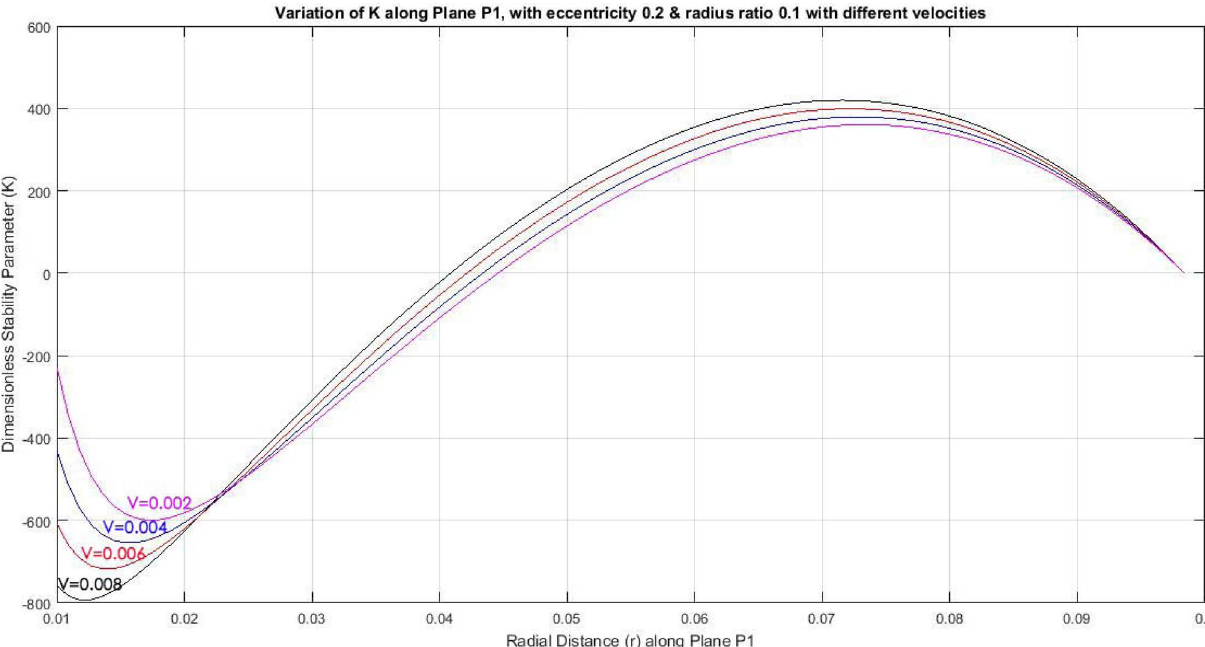
Fig. 8 Variation of K along Plane P